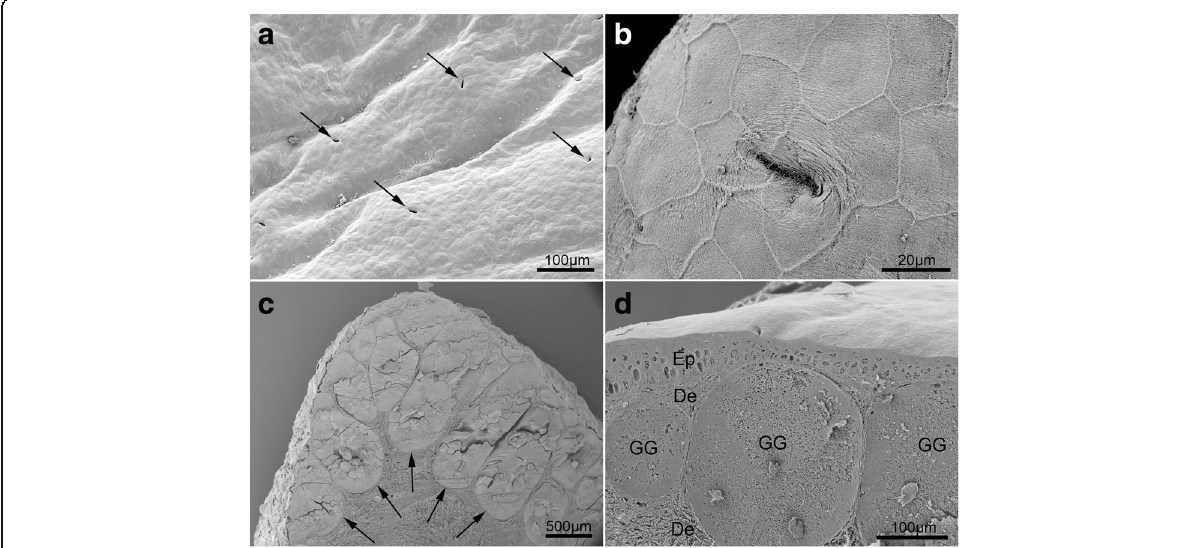
Fig. 1 Scanning electron micrographs showing the skin surface ( a , b ) and sections through the skin ( c , d ) of T. verrucosus . a Overview of the skin surface in the dorsal trunk region with numerous gland pores (indicated by arrows). b Detail showing a single gland pore and surrounding epithelial cells. c Section through the left parotoid gland. Note the densely packed granular (poison) glands indicated by arrows. d Section through the dorsal trunk region with roundish poison glands just beneath the epithelium. De, dermis; Ep, epithelium, GG, granular